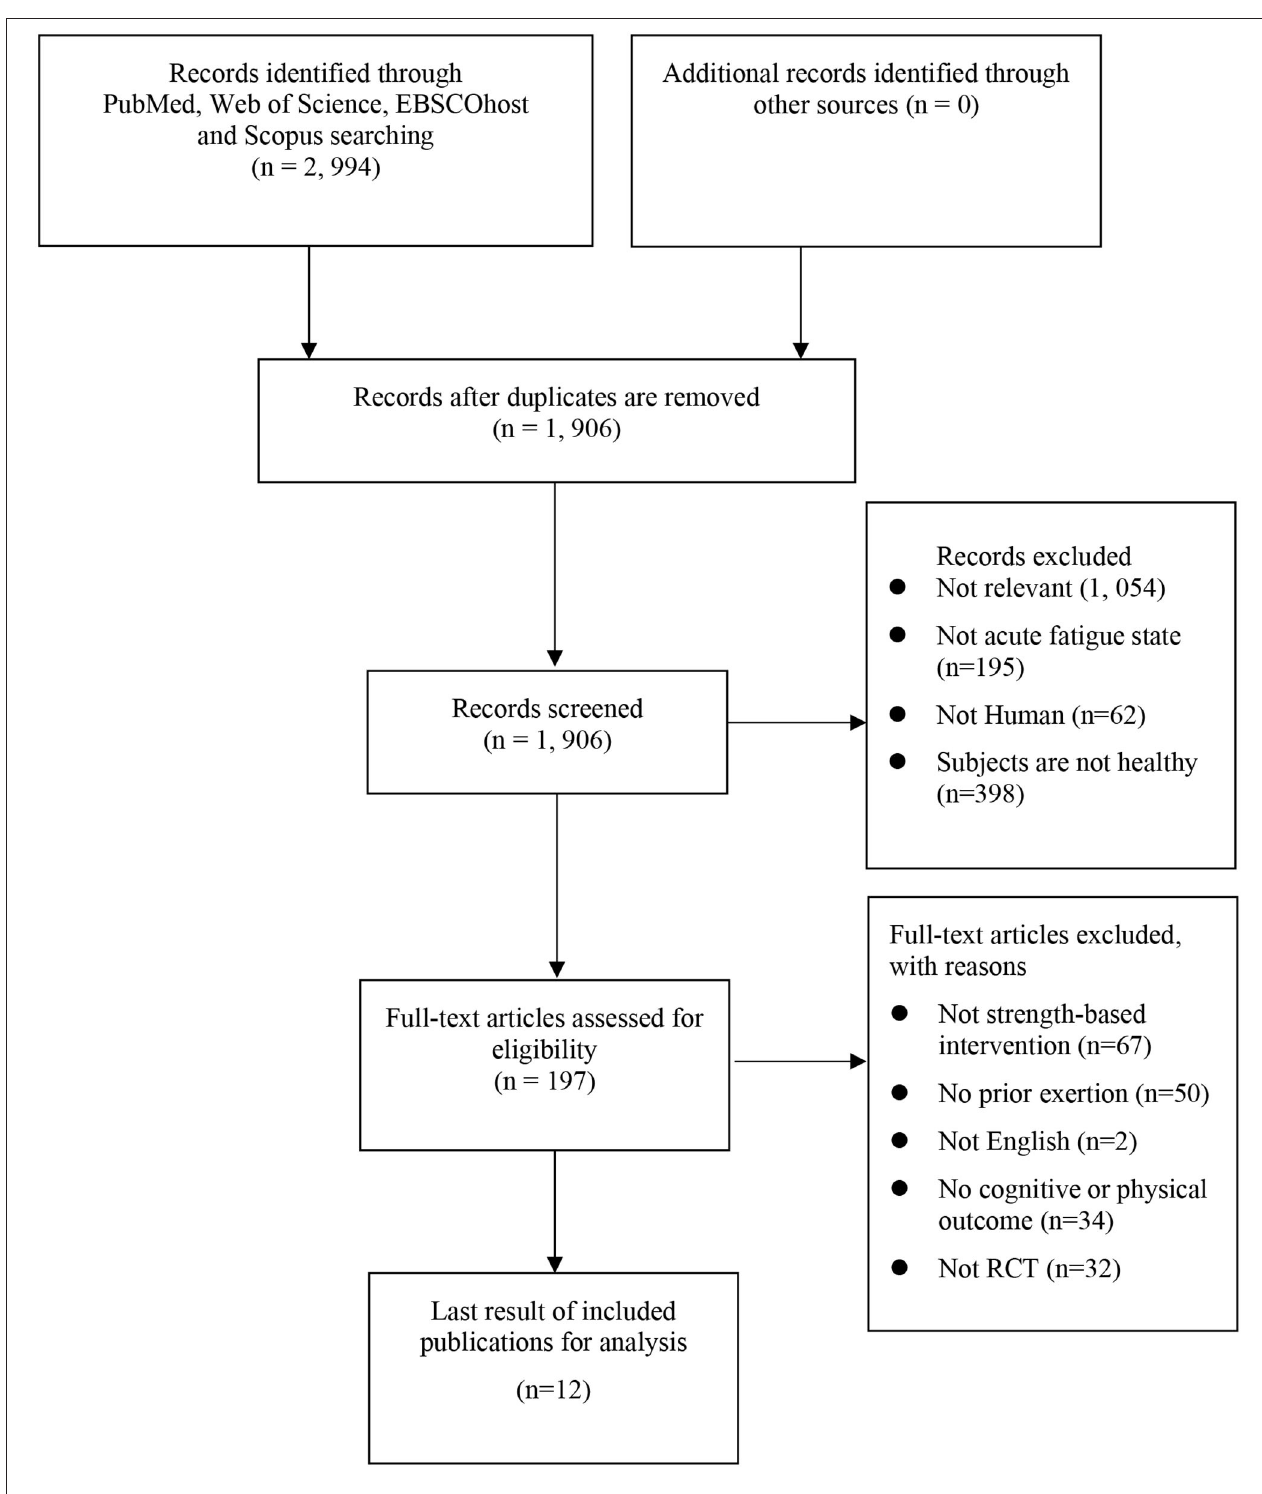
FIGURE 1 | PRISMA summary of the selection procedure.